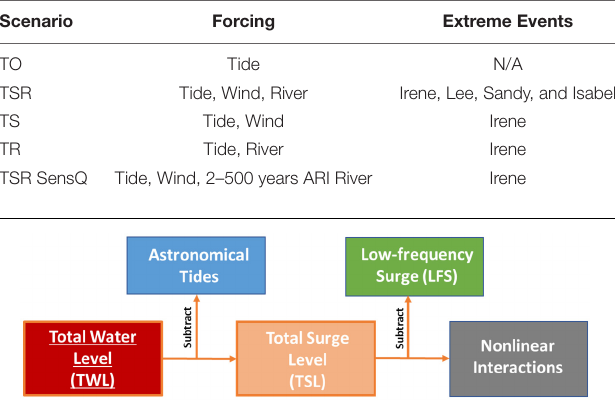
FIGURE 4 | Flowchart of decomposing the TWL into tides, low-frequency surge, and non-linear interactions. TWL = Tides + LFS + Non-linear